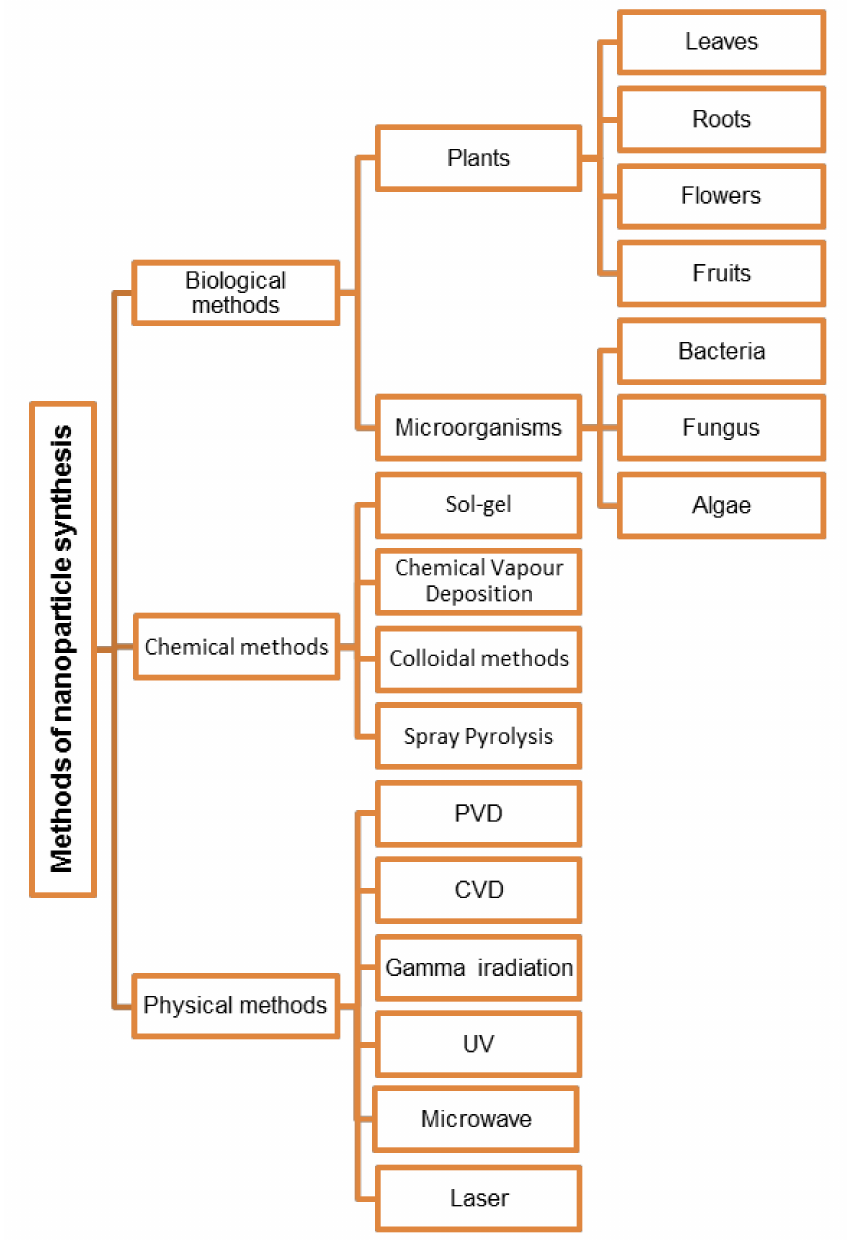
Figure 1. Methods for production of metal